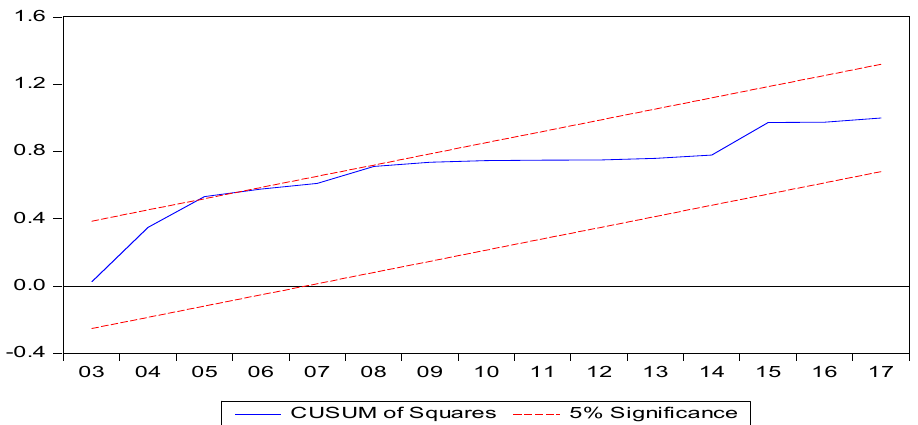
Figure 2. Represents the cumulative sum of square (CUSUMSQ).